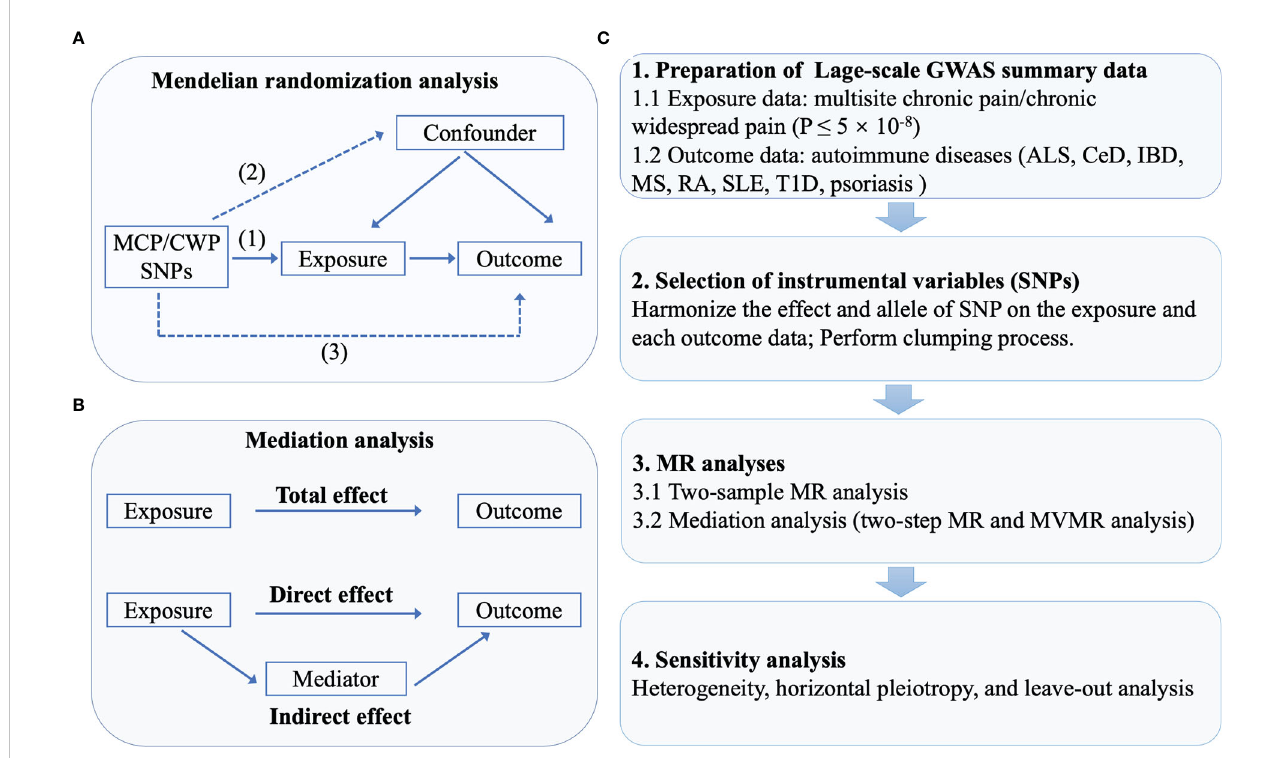
FIGURE 1 The fl owchart of the study. (A) The principles for mendelian randomization study are as follows: (1) genetic instrumental variables are associated with the exposure, (2) genetic instrumental variables are independent of confounding variables, (3) genetic instrumental variables only affect outcome through exposure. (B) In mediation analysis, the total effect was decomposed into direct effect and indirect effect (derived by subtracting direct effect from total effect). (C) The whole work fl ow of MR